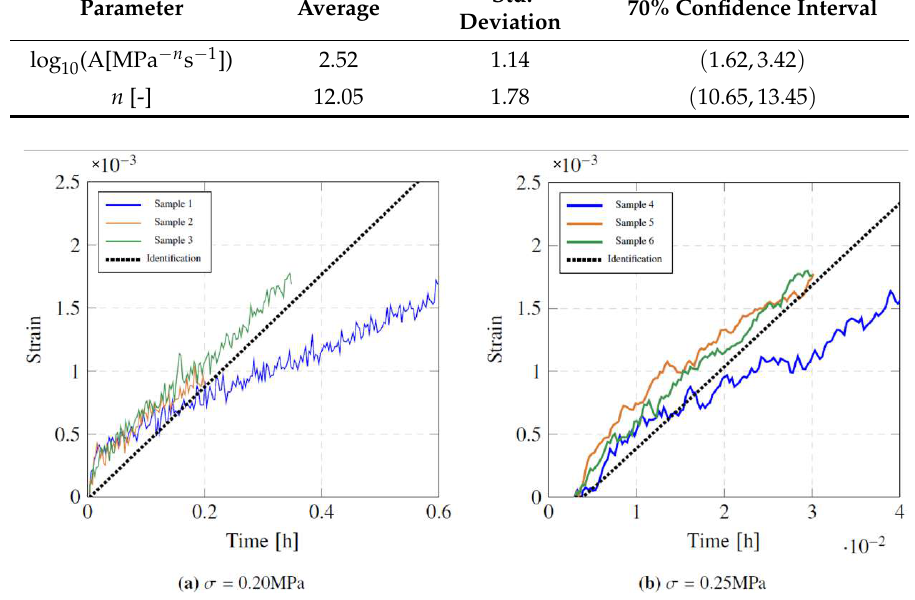
Figure 7. Tensile creep identification results at T = 1300 ◦ C.